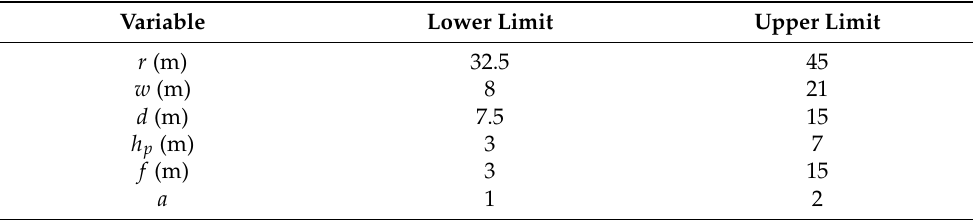
Table 1. Input variables’